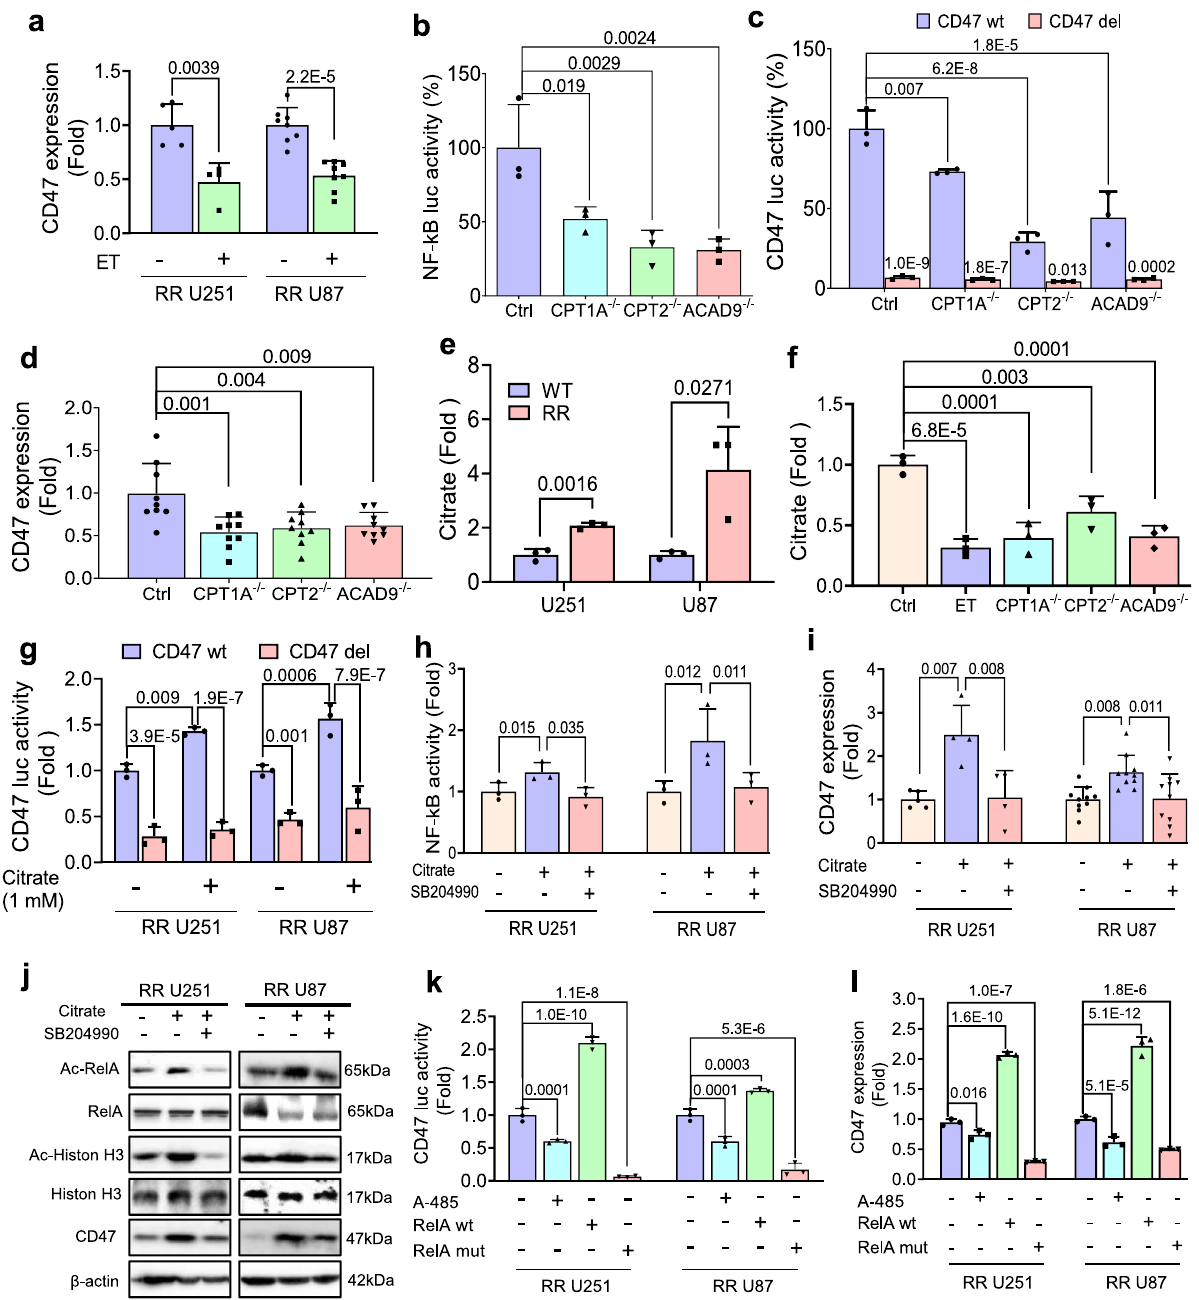
Fig. 4 FAO regulates CD47 transcription via citrate/acetyl-CoA mediated RelA acetylation. a CD47 mRNA levels in RR U251 ( n = 5, P = 0.0039) and RR U87 ( n = 8, P = 2.2E-5) cells treated with CPT1A inhibitor etomoxir (ET; 200 µ M, 24 h). An unpaired two-tailed t -test was applied. NF- κ B reporter b or CD47 promoter activity c in RR U251 cells compared to CPT1A − / − , CPT2 − / − , and ACAD9 − / − RR U251 cells (in c , CD47 promoter with NF- κ B motif deleted as the negative control ( n = 3). ANOVA one-way test was applied in b and ANOVA two-way test was applied in c . d CD47 mRNA levels in CPT1A − / − , CPT2 − / − , and ACAD9 − / − RR U251 cells. n = 9. ANOVA one-way test was applied. e Citrate concentrations measured in WT and RR GBM (U251 and U87) cells ( n = 3). An unpaired two-tailed t -test was applied. f Citrate concentrations measured in CPT1A − / − , CPT2 − / − , and ACAD9 − / − or ET-treated RR U251 cells ( n = 3). ANOVA one-way test was applied. g CD47 promoter-controlled luciferase activity with or without NF- κ B motif deletion measured in RR U251 and RR U87 cells treated with citrate (1 mM, 6 h) ( n = 3). ANOVA two-way test was applied. h NF- κ B luciferase activity in RR U251 and RR U87 cells treated with citrate (1 mM, 6 h) in the presence or absence of ACLY inhibitor SB204990 (25 µ M, 24 h) ( n = 3). ANOVA one-way test was applied. i CD47 mRNA level in RR U251 ( n = 4) and U87 ( n = 10) cells treated with citrate (1 mM, 6 h) combined with or without ACLY inhibitor SB204990 (25 µ M, 24 h). j Western blot of RelA K310 acetylation, Histone 3 acetylation in RR U251 and RR U87 cells treated with citrate (1 mM, 6 h) with or without SB204990 (25 µ M, 24 h) ( n = 3 experiments). k CD47 promoter-controlled luciferase activity either treated with A-485 (20 μ M, 24 h) or with or without RelA mut measured in RR U251 and RR U87 cells. l CD47 mRNA level in RR U251 and U87 cells treated with A-485 (20 μ M, 24 h) or transfected with WT or mutant RelA. In k and l , n = 3, ANOVA one-way test was applied. Results represent means ± SD. Source data are provided as a Source Data fi le.